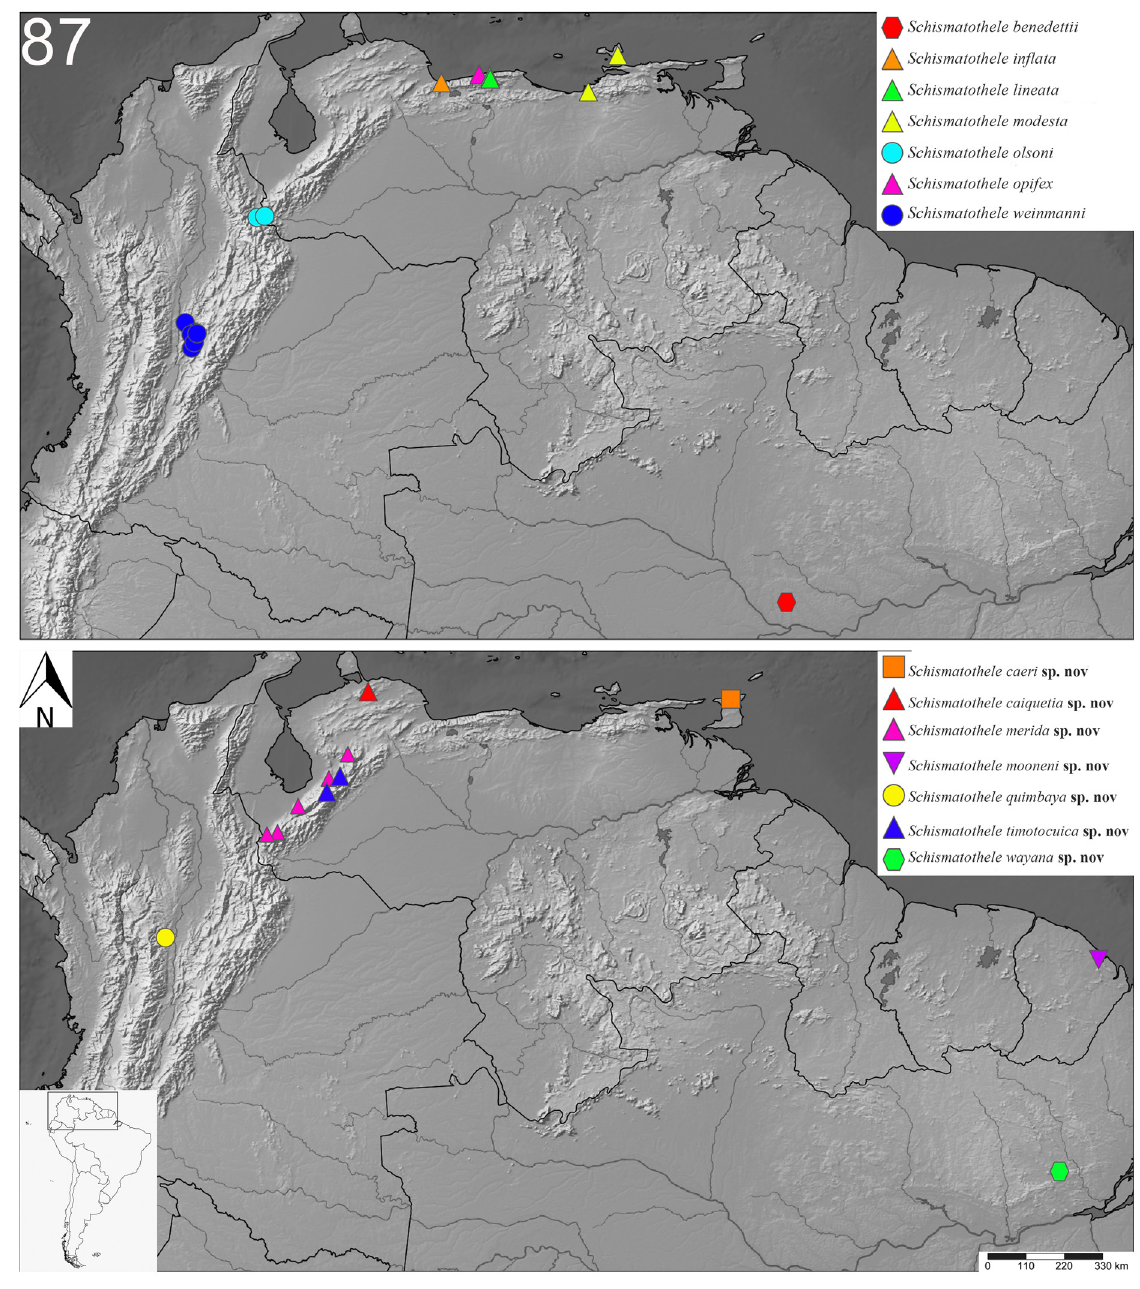
Fig. 87 . Distribution map for species of Schismatothele Karsch,